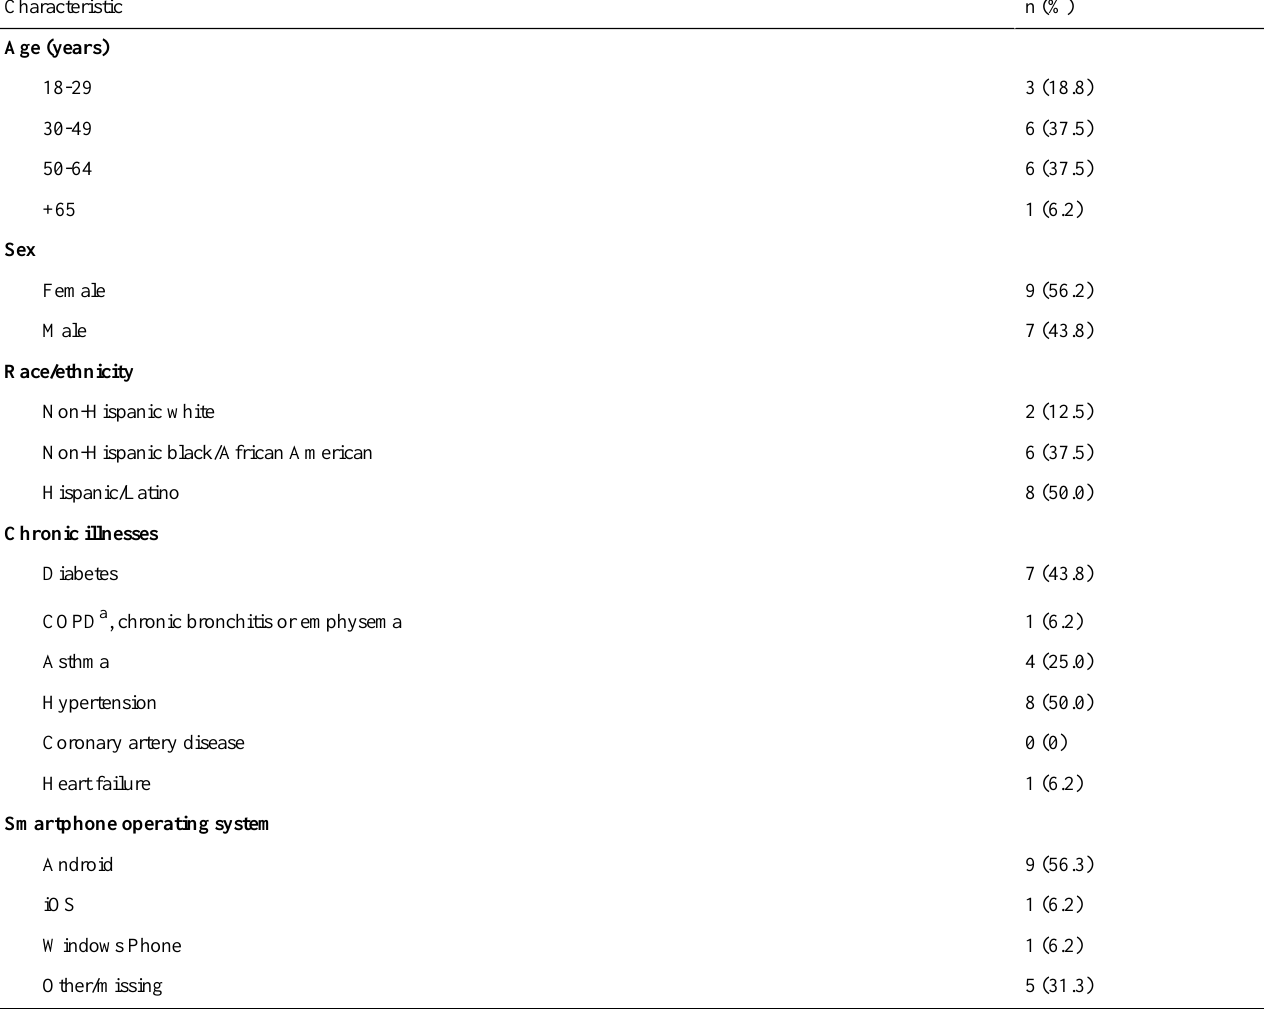
Table 1. Participant characteristics for patient focus groups